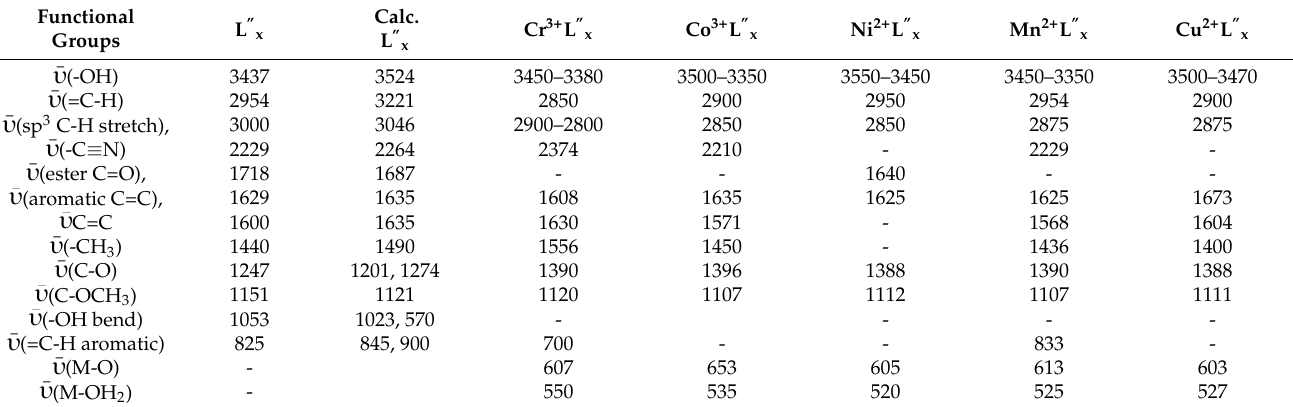
Table 3. Characteristic FTIR bands of the MBH Adduct (L ” x ) and its metal complexes (cm − 1 ) ῡ .